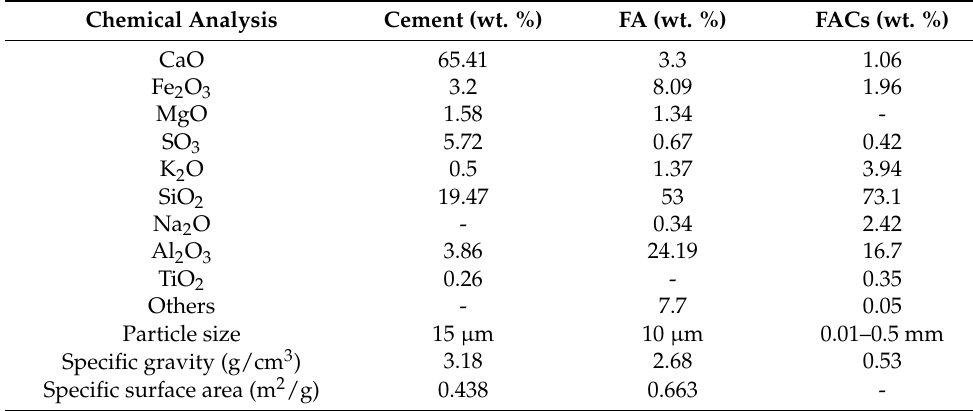
Table 1. Chemical composition and physical properties of main raw materials.